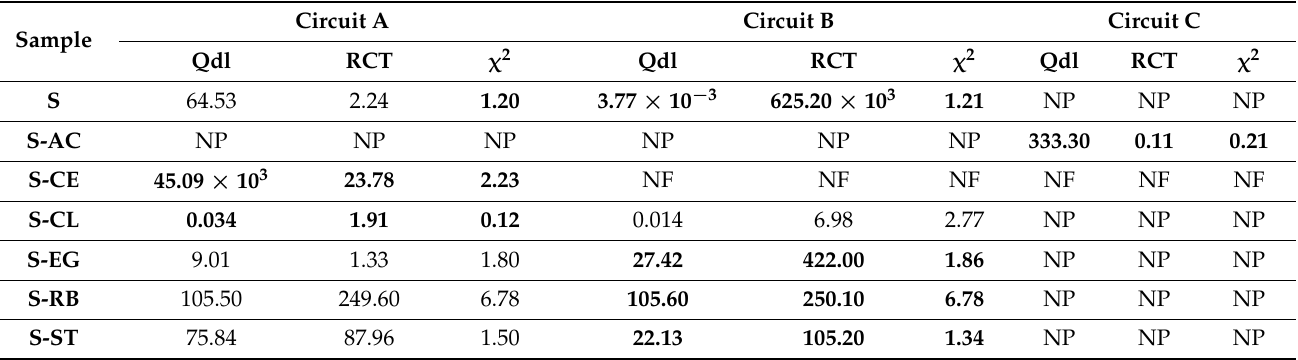
Table 3. Fitted Qdl (nF cm − 2 s − (1 − α c) ), RCT (M Ω ), and χ 2 (goodness of fit, × 10 3 ) parameter values of S-coated samples of EC presented in Figure